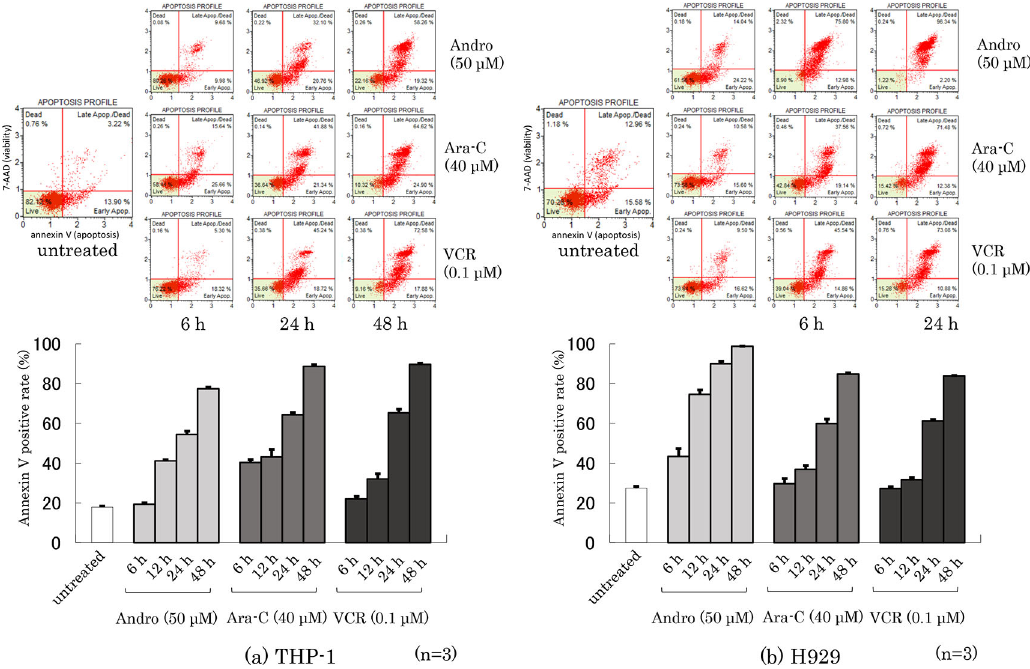
Figure4.RatesofAnnexinV-positivecellsaftertreatmentfor6~48hwithAndro,Ara-C,orVCRofTHP-1(a)and H929 (b) cells. Labeling with Annexin V and 7-AAD were analyzed by the Muse Cell Analyzer. The upper figures show representative dot plots in which the x-axis indicates Annexin V labeling and the y-axis indicates 7-AAD labeling.